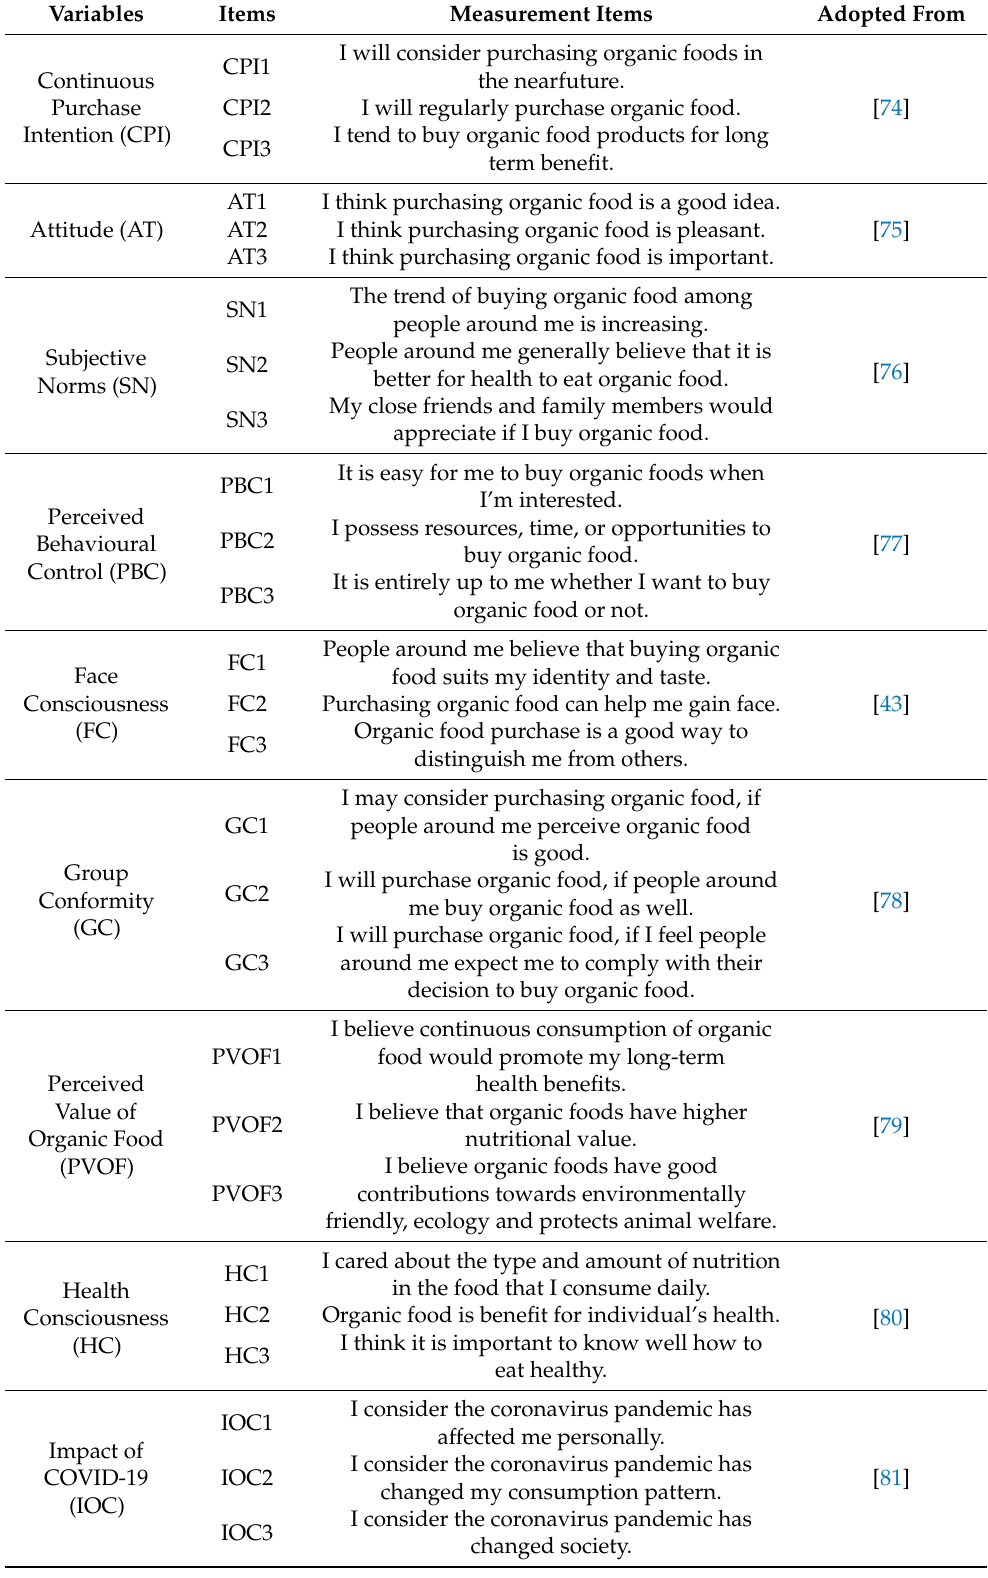
Table 1. Questionnaire items and their source of